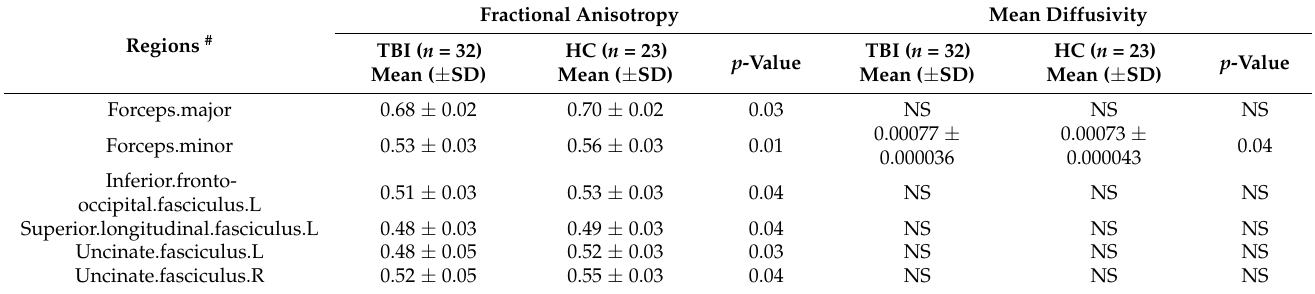
Table 4. Significant outcome of WM integrity between TBI patients and healthy